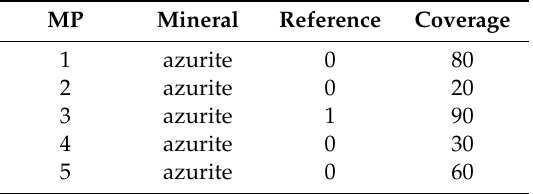
Figure 4. Image of azurite sample measuring points. Table 2. Example description table of the sample shown in Figure 4.